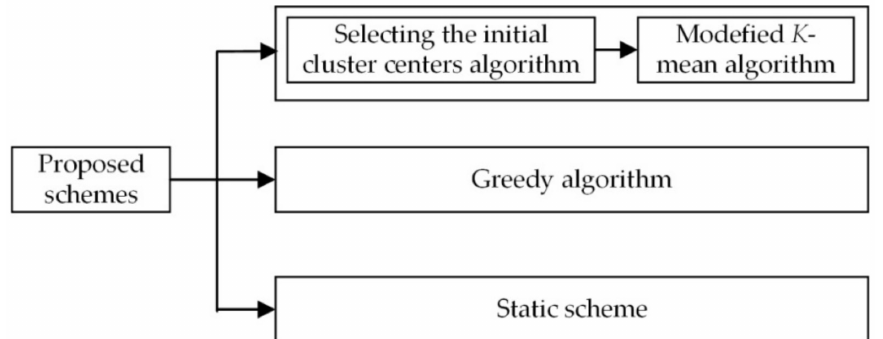
Figure 3. Three possibilities when determining an available flight path according to the target sensor location.